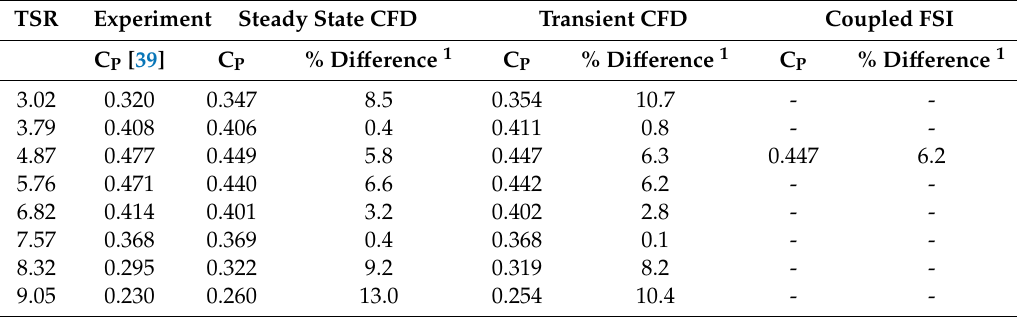
Table 3. Quantitative comparison of turbine C P between simulations and experiment.